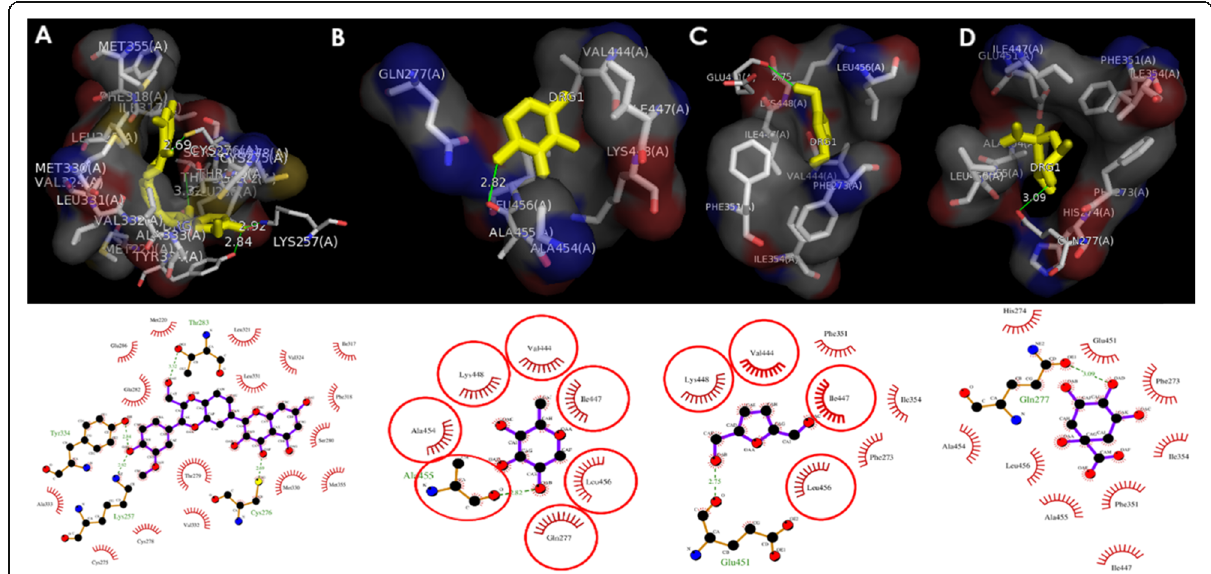
Fig. 5 Ligplot analysis and docking in relation to TGF- β 1. a Crystal structure of TGF- β 1, ligand Silymarin (Standard drug), b , c , d Crystal structures